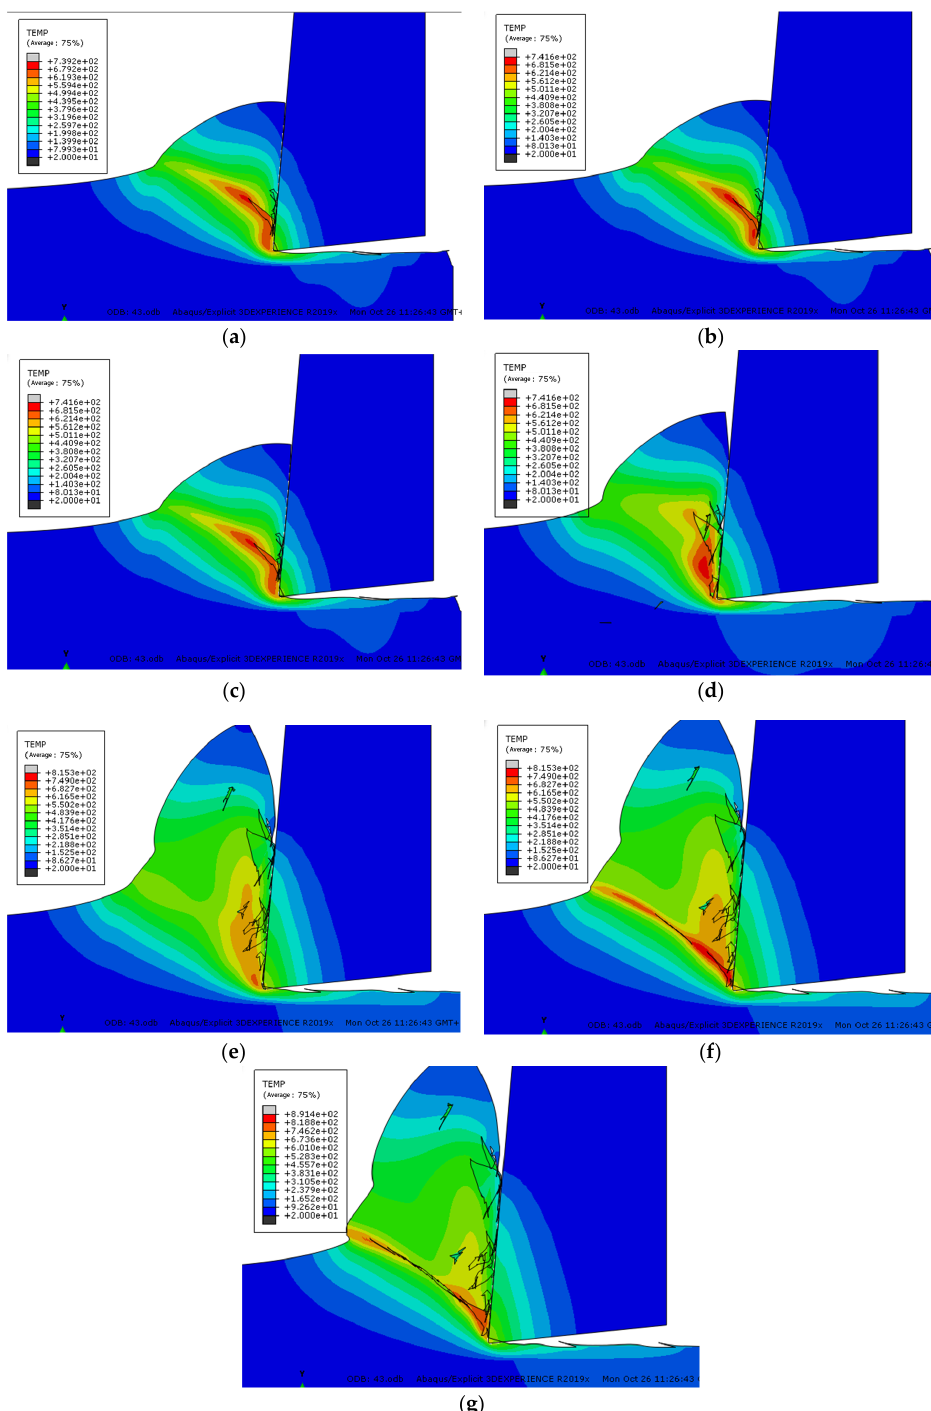
Figure 9. Changes in the cutting temperature field during the formation of serrated chips (°C). ( a ) The first section is aboutto be formed.( b ) The first block isfully formed. ( c ) The second block begins to form.( d ) The second nodal development process. ( e ) The second nodal mass starts to slip. ( f ) The second nodal slip process. ( g ) The second block is fully formed.